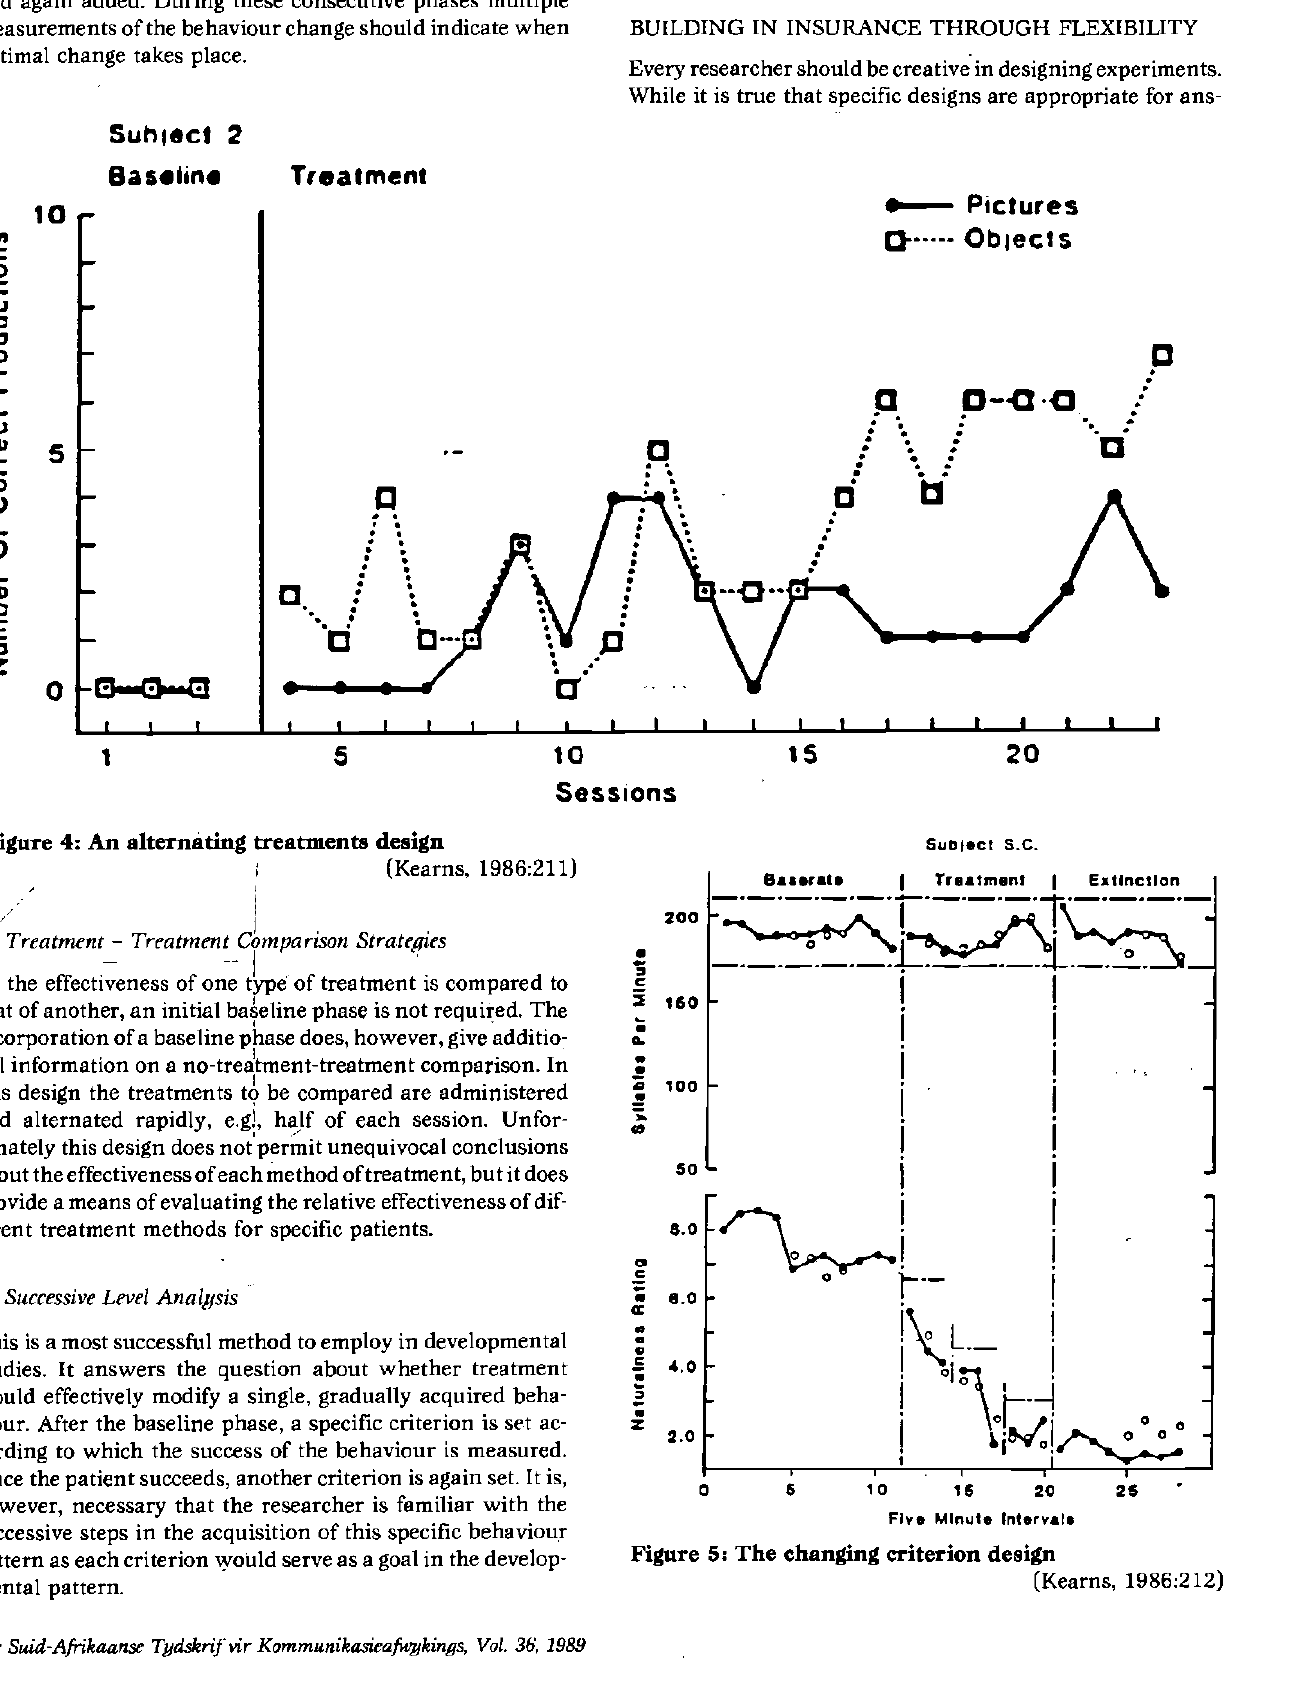
Figure 5: The changing criterion